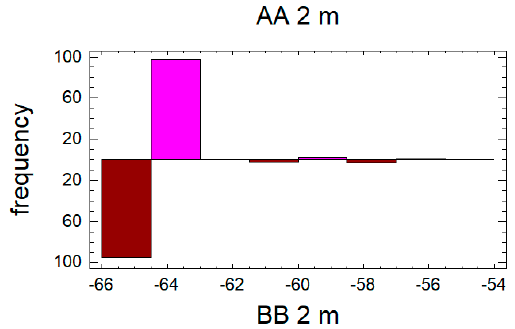
Figure 4. Histogram for reading distance 2 m.